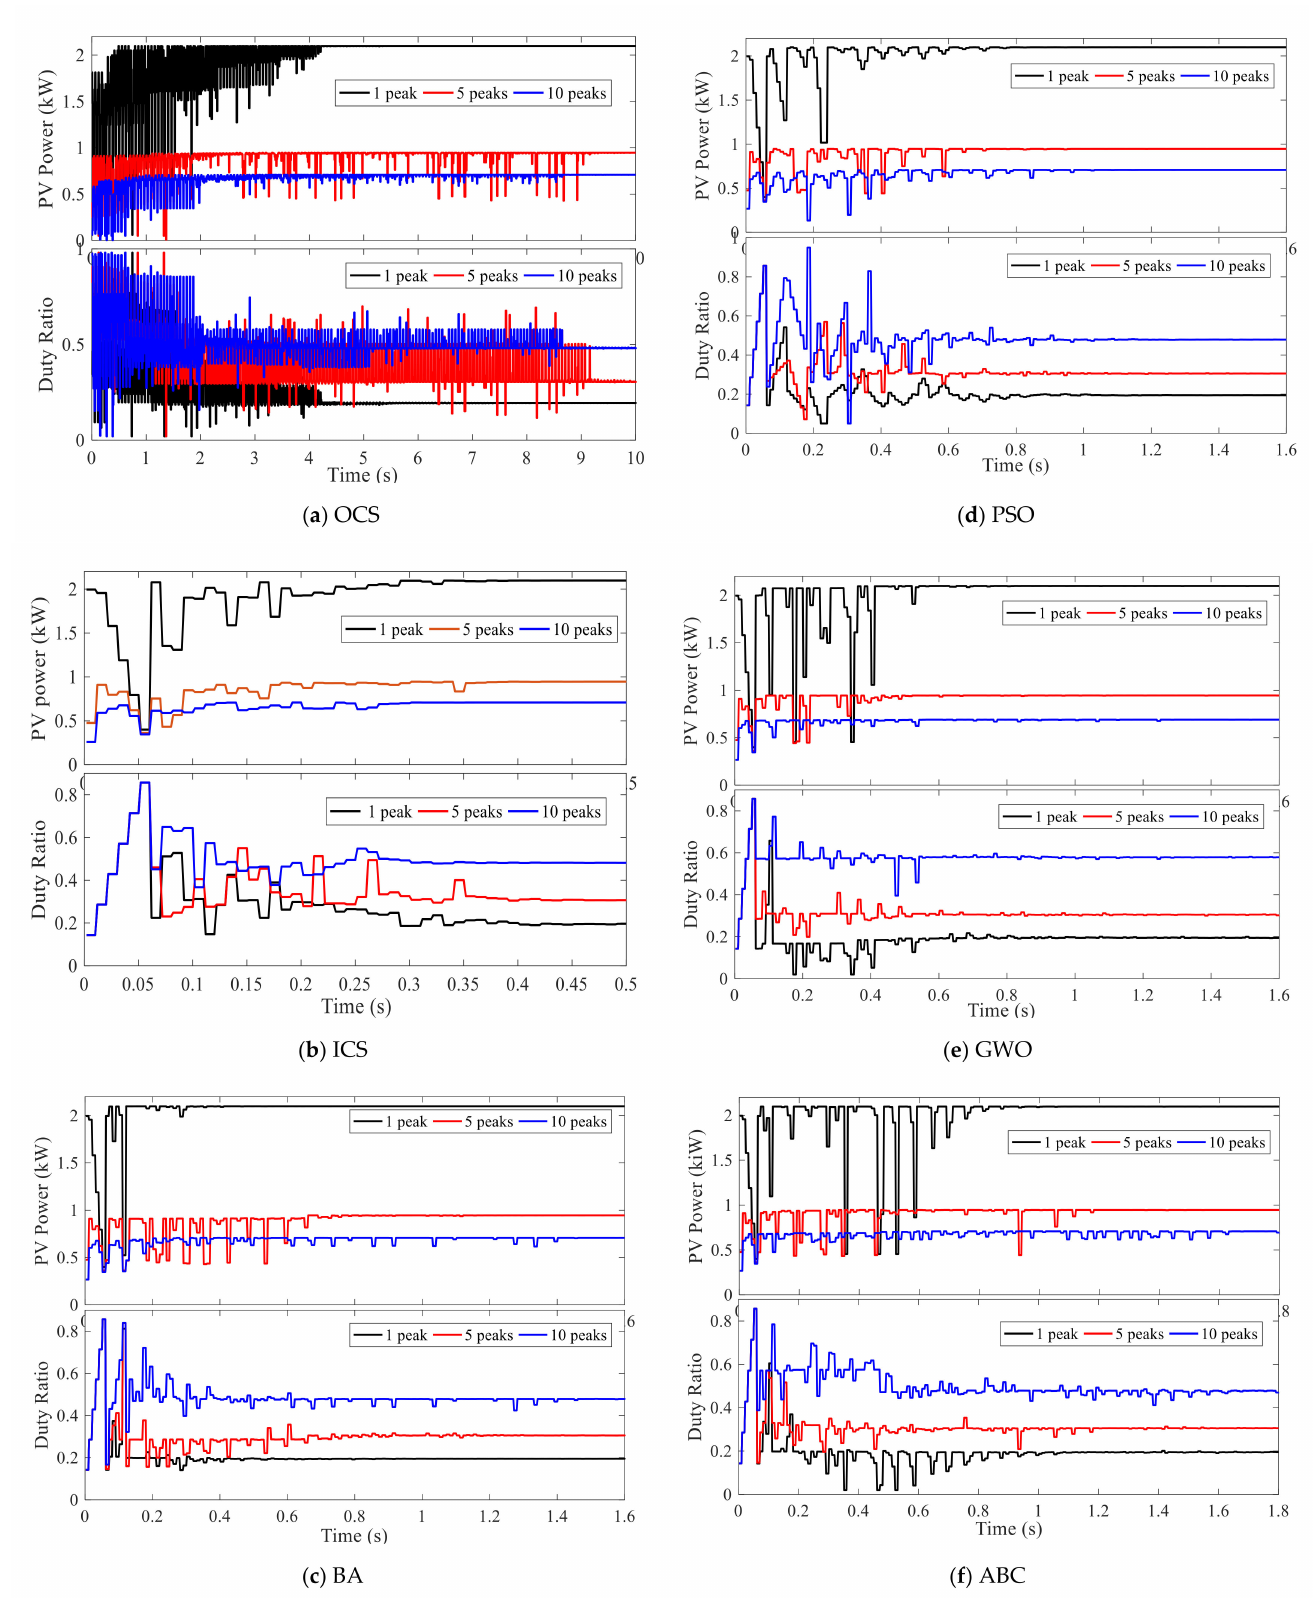
Figure 11. The time variation of generated power and duty ratio of boost converter for all SOTs at a different number of